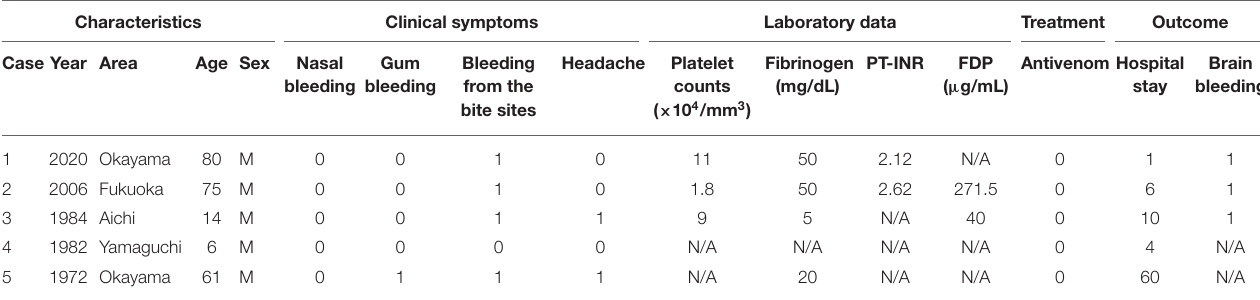
TABLE 3 | Clinical characteristics of fatal cases among R. tigrinus bite patients in Japan (1971–2020).